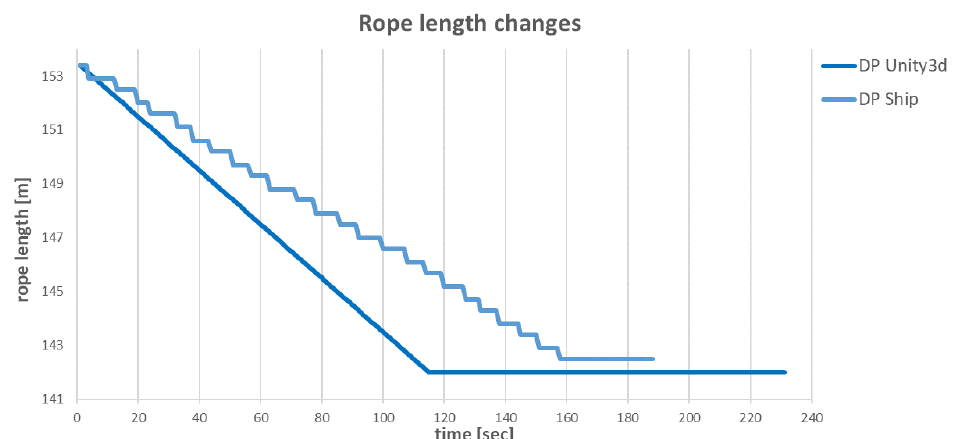
Figure 34. Changes in BP rope lengths over time.